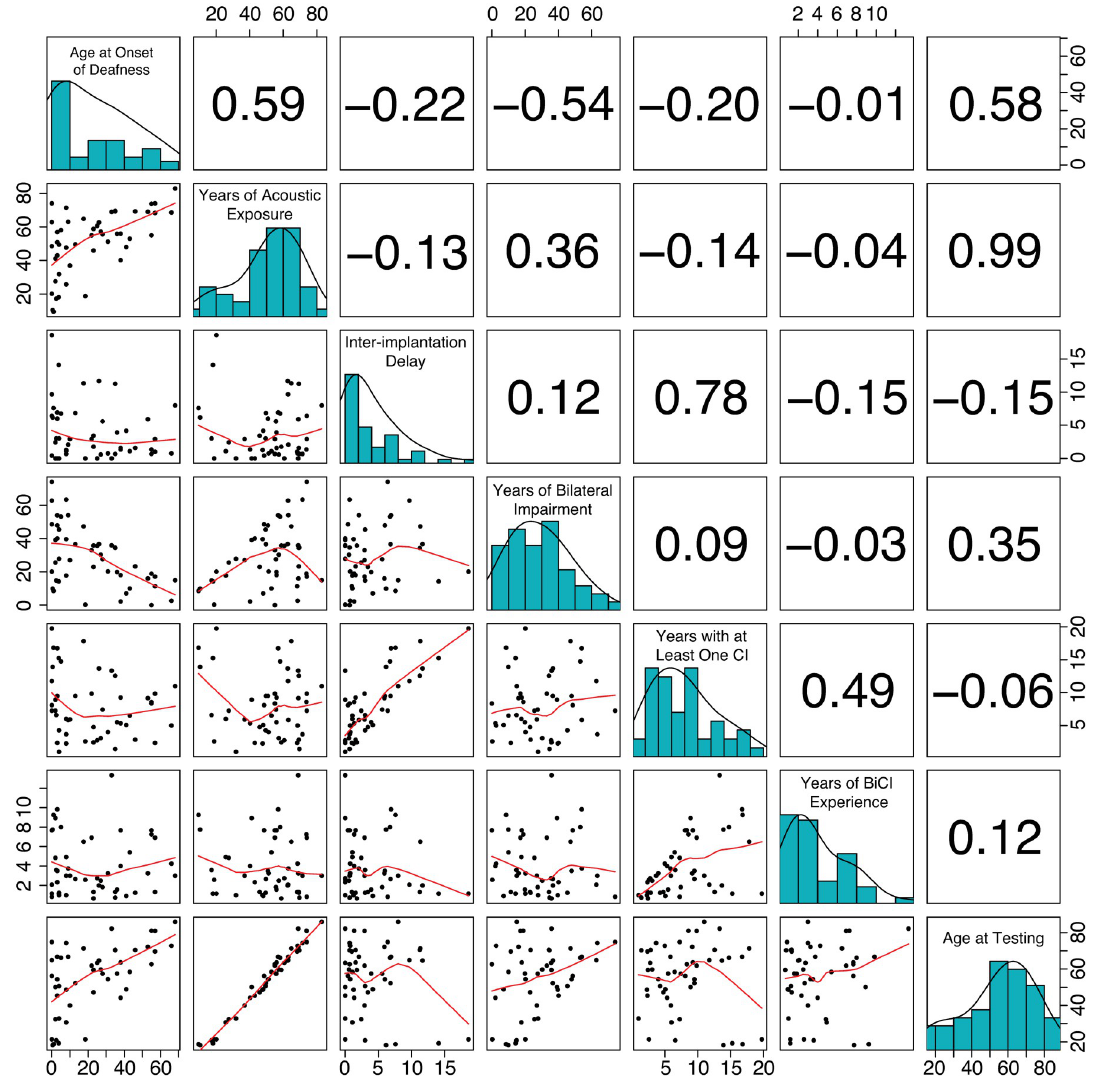
Fig 2. Relationship between patient-dependent factors. Each row and column correspond to a different patient-dependent factor that is given along the diagonal with a histogram showing its values. Values in each cell of the upper-triangle correspond to Pearson correlation coefficients. Plots in each cell of the lower-triangle show the relationship between two